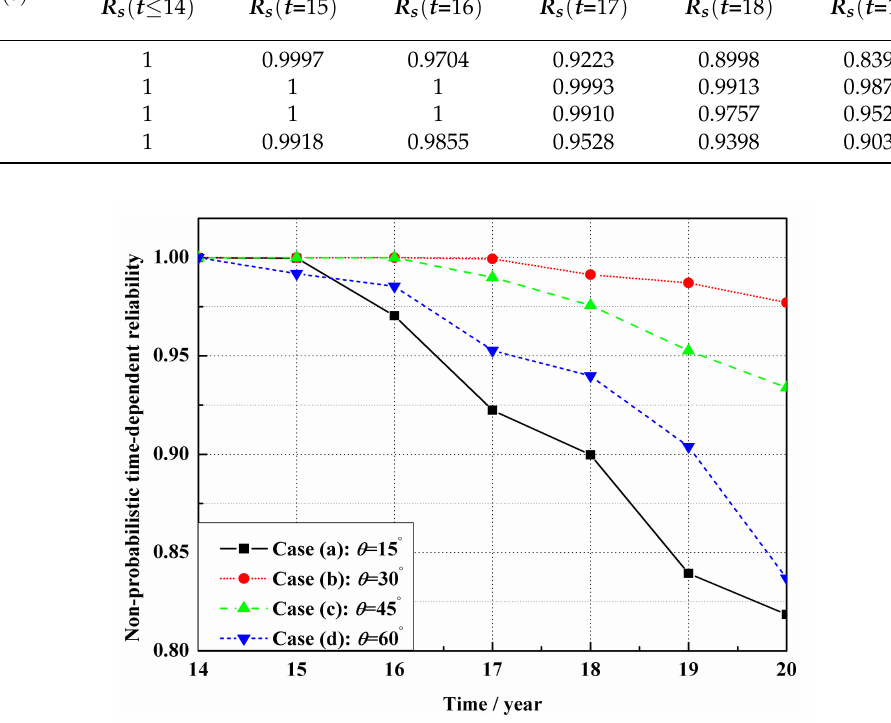
Figure 9. Non-probabilistic time-dependent reliability results versus different values of ply angel θ .